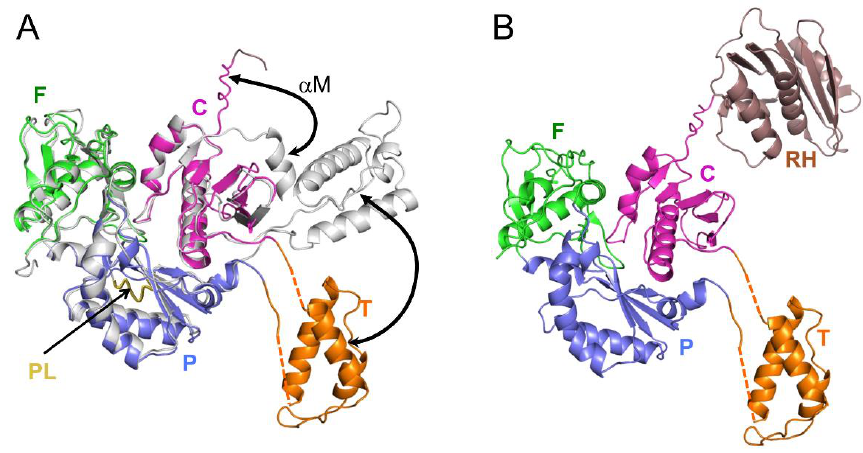
Figure 3. The p51 and p66 monomer structures. ( A ) Ribbon diagram of the p51∆PL monomer overlaid with the p51 subunit of RT (PDB ID: 1S9E). Structure 1S9E (gray) corresponds to an inhibitor complex, and includes the palm (P) loop segment (residues 219–230), which forms a loop at the rear of the structure (gold). The two major differences relative to the p51 subunit of RT are the disordered position of the thumb (T) and the C-terminal residues 420–430, which form helix α M’ in the p51 subunit; ( B ) Ribbon visualization of the p66 monomer based on the crystal structure shown in panel A and nuclear magnetic resonance (NMR) data indicating resonances of the RH domain in close agreement with those of the isolated domain. The unfolded C-terminus of the connection (C) domain in A links the polymerase and RH domains. Domain color coding as in Figure 2.